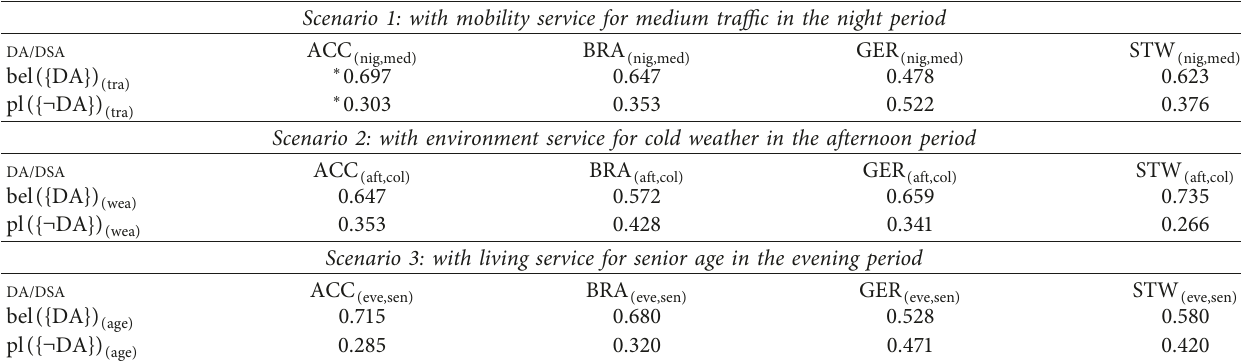
Table 4: Belief values of DA with one activated sensor combined with one service in different scenarios.